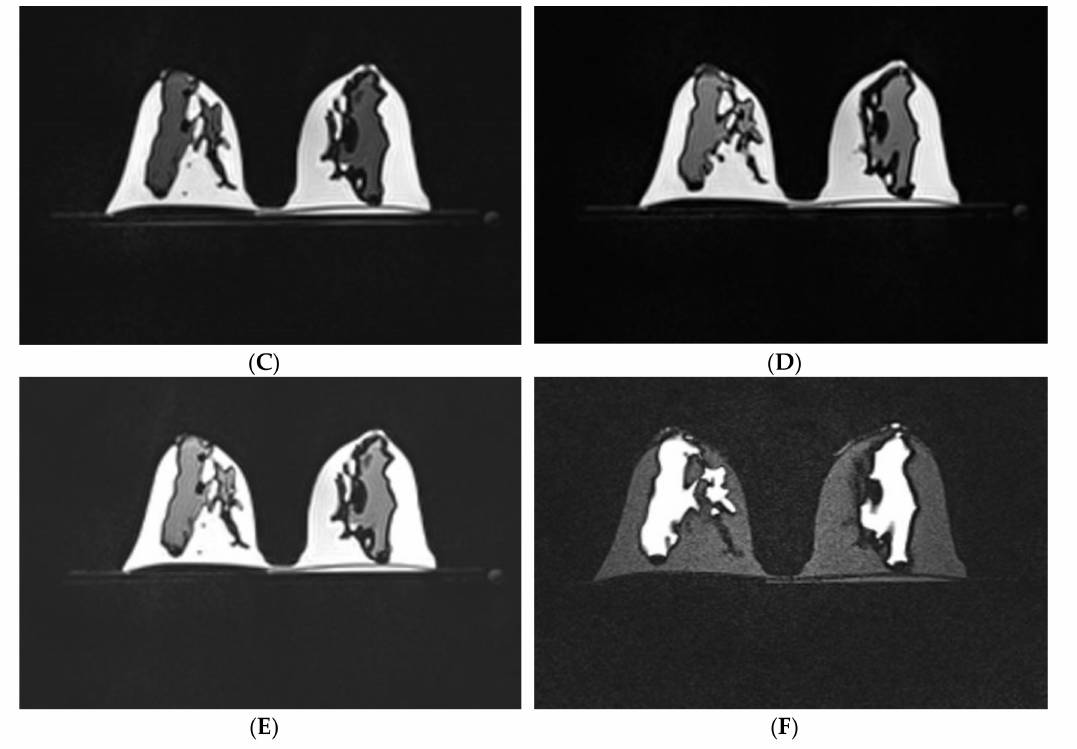
Figure 2. Central axial slice of a personalized 3D-printed breast model for the di ff erent MR imaging pulse sequences. ( A ) Non-fat-suppressed TSE (T2W); ( B ) Non-fat-suppressed TSE (T1W); ( C ) Non-fat-suppressed TSE SPACE (T1W); ( D ) Fat-suppressed TSE SPACE (T1W); ( E ) Fat-suppressed TSE SPACE SPAIR (T1W); ( F ) Fat-suppressed IR / PFP TIRM (T2W). For pulse sequences, refer to Table